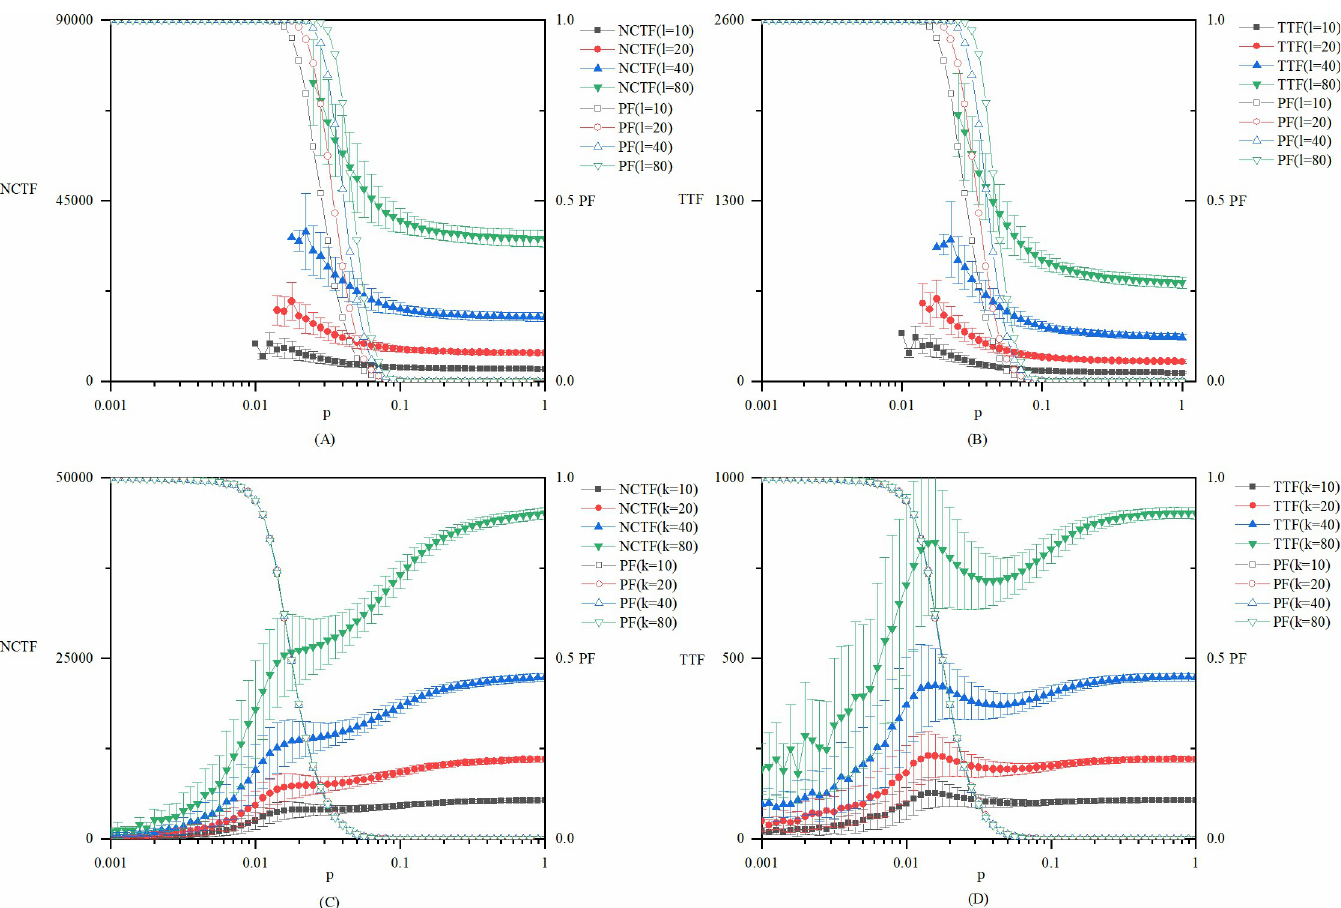
Fig 7. Robustness test of the innovation model parameters k and l. (A) NCTF and PF of explorative innovations with different values of l , which is the number of dimensions of the innovation vector L . (B) TTF and PF of explorative innovations with different values of l . (C) NCTF and PF of exploitative innovations with different values of k , which is the amount of knowledge in each dimension of the innovation vector L . (D) TTF and PF of exploitative innovations with different values of k .